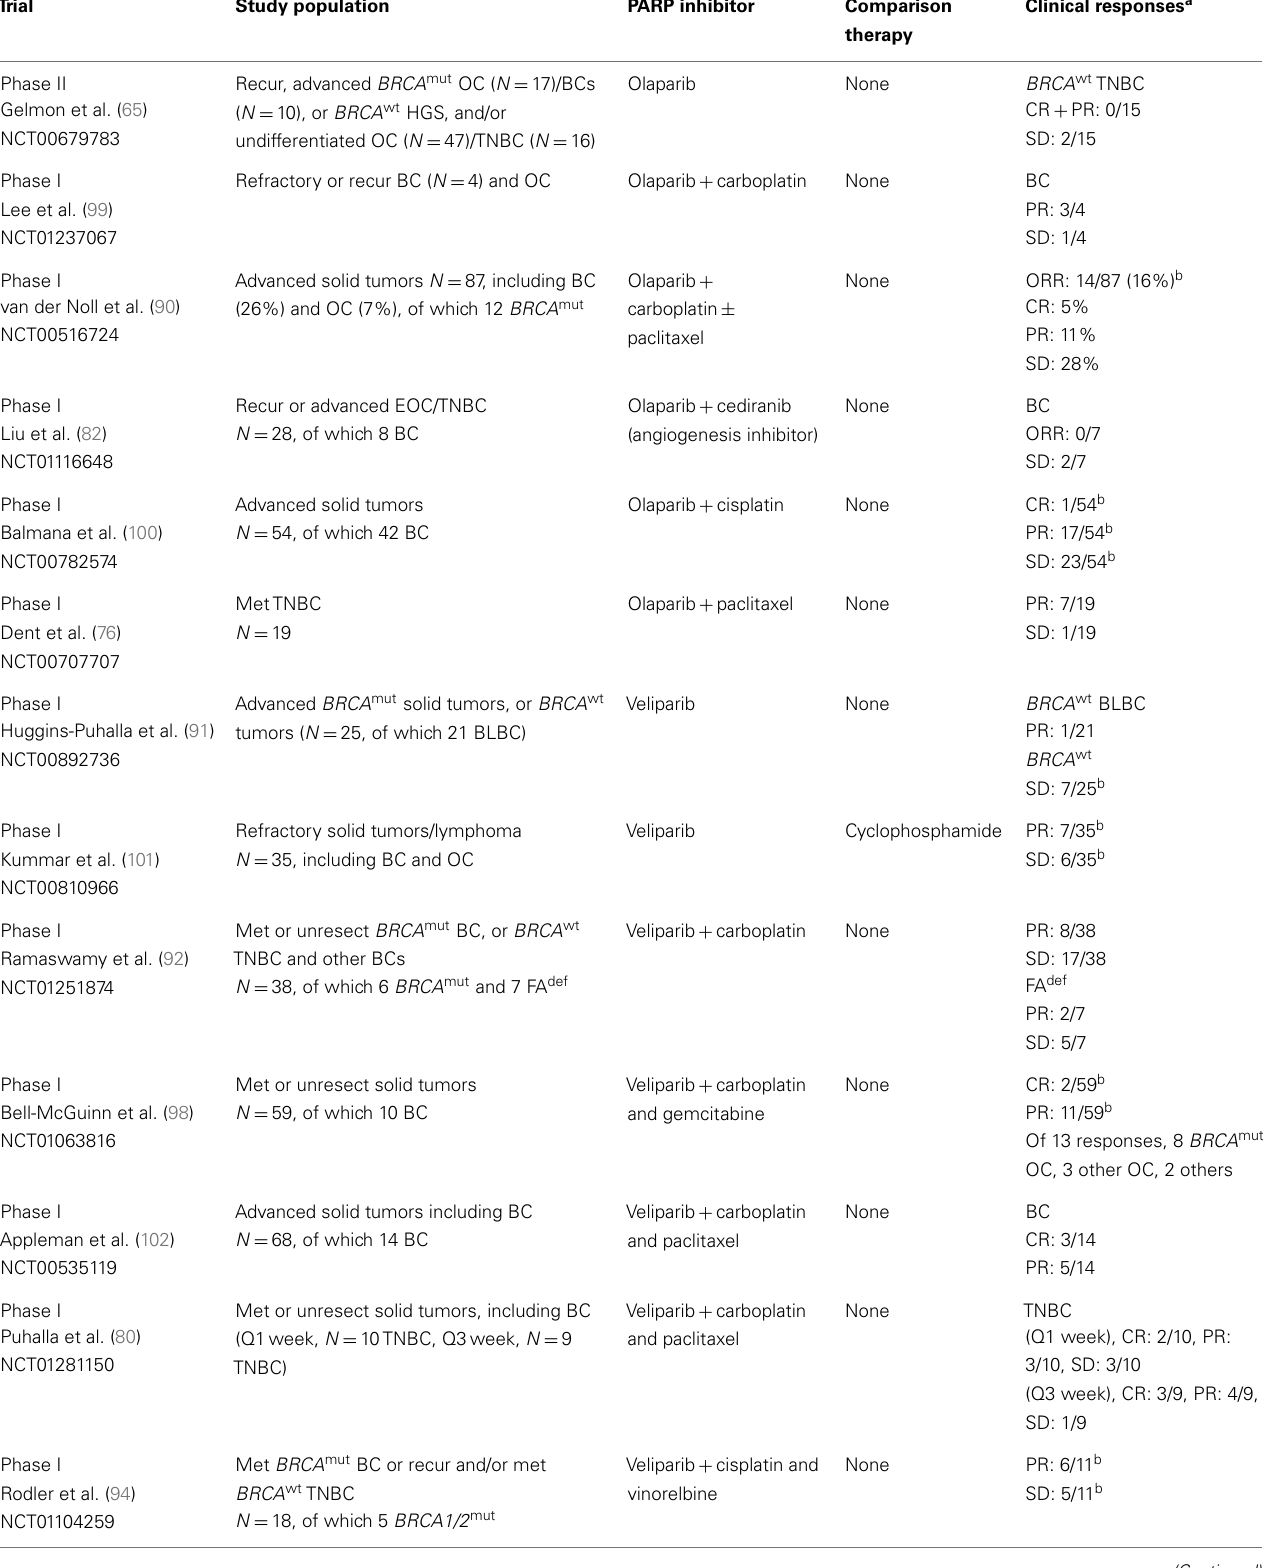
Table 3 | Selected PARP inhibitor trials in sporadic breast cancers